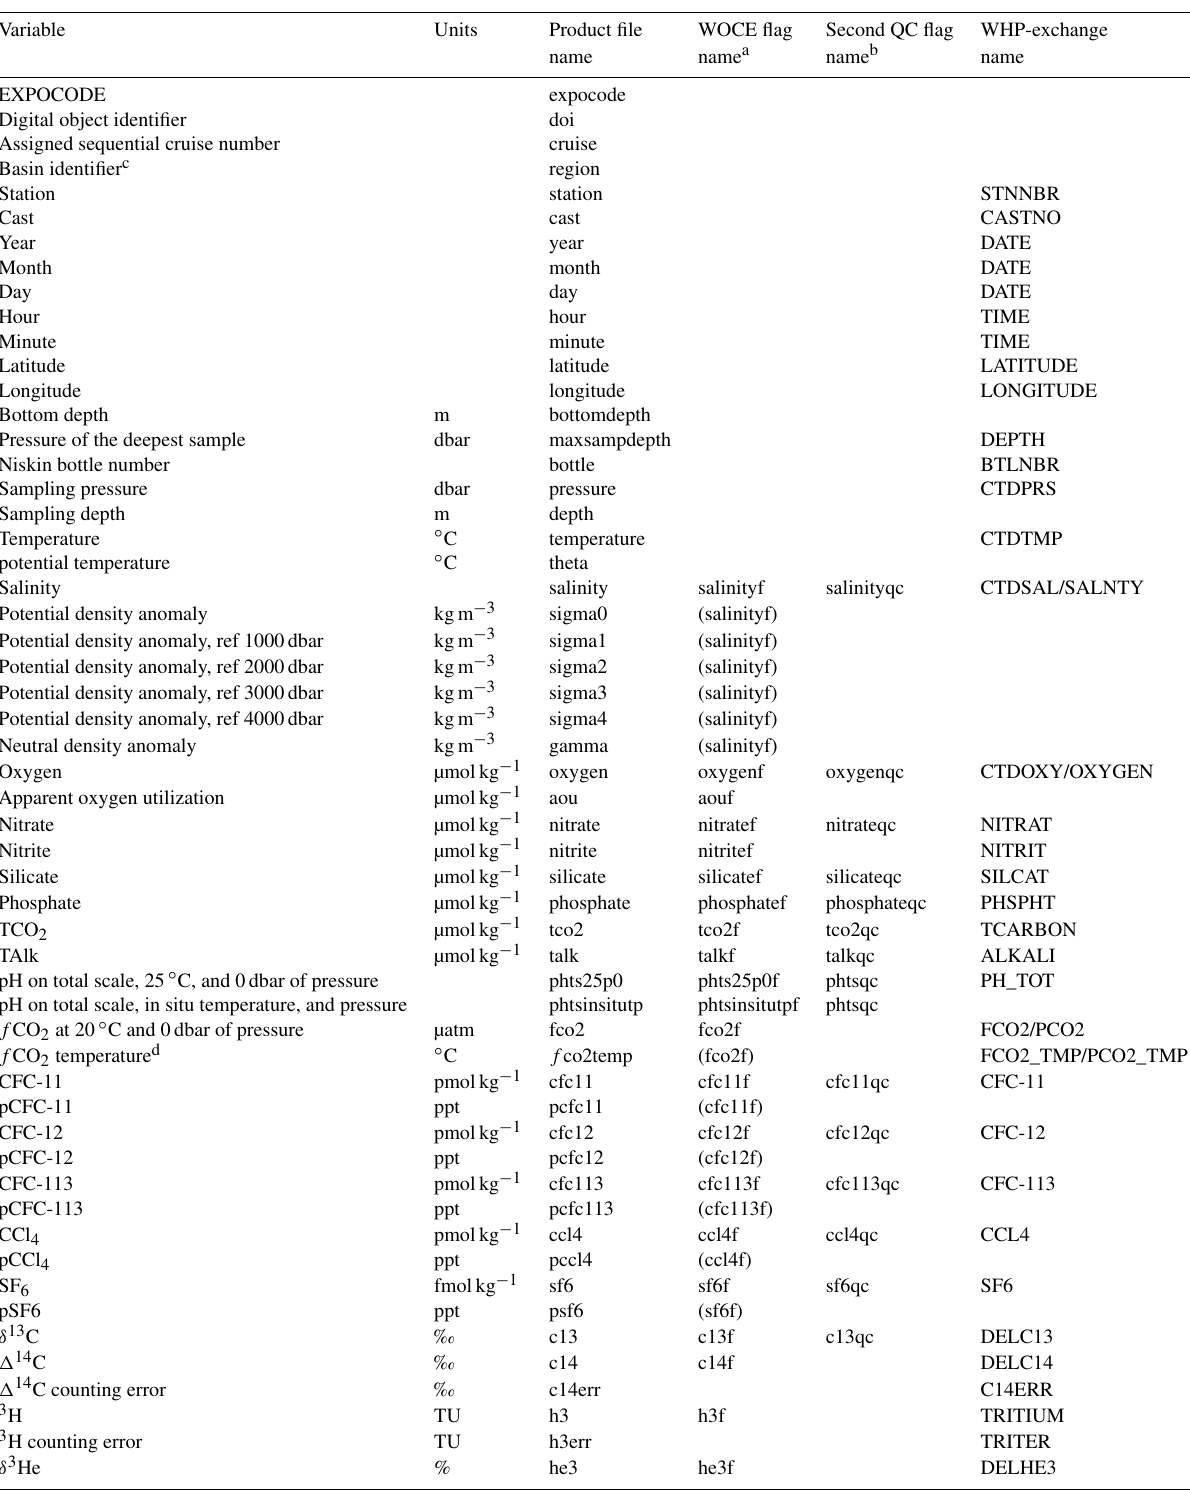
Table 1. Variables in the GLODAPv2.2022 comma separated (csv) product files, their units, short and flag names, and corresponding names in the individual cruise exchange files. In the MATLAB product files that are also supplied a “G2” has been added to every variable name (e.g.,